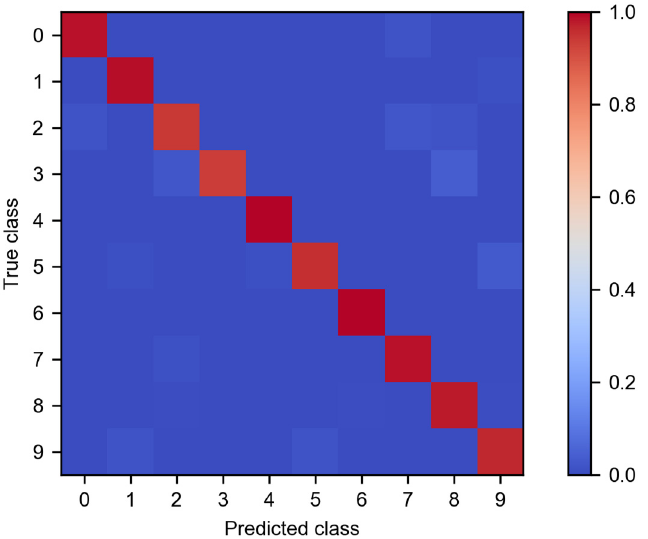
Fig 4. Confusion matrix of the classification result on the test set. The diagonal values indicate the ratio of correct classifications for each digit, while off-diagonal values represent the misclassifications.